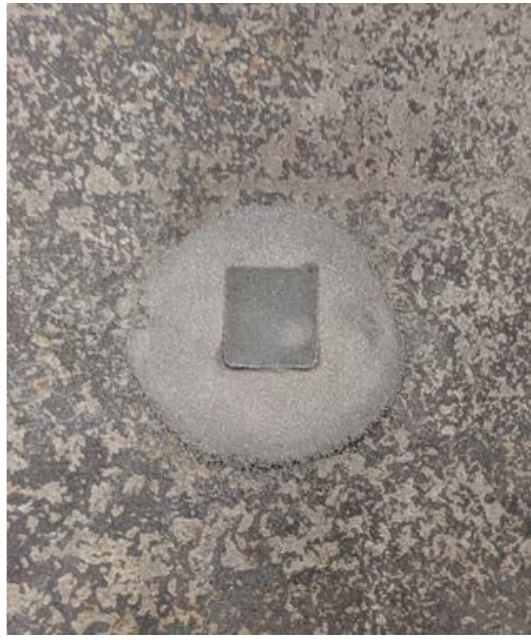
Figure A20. A square shaped HEA printing using selective laser melting technique.